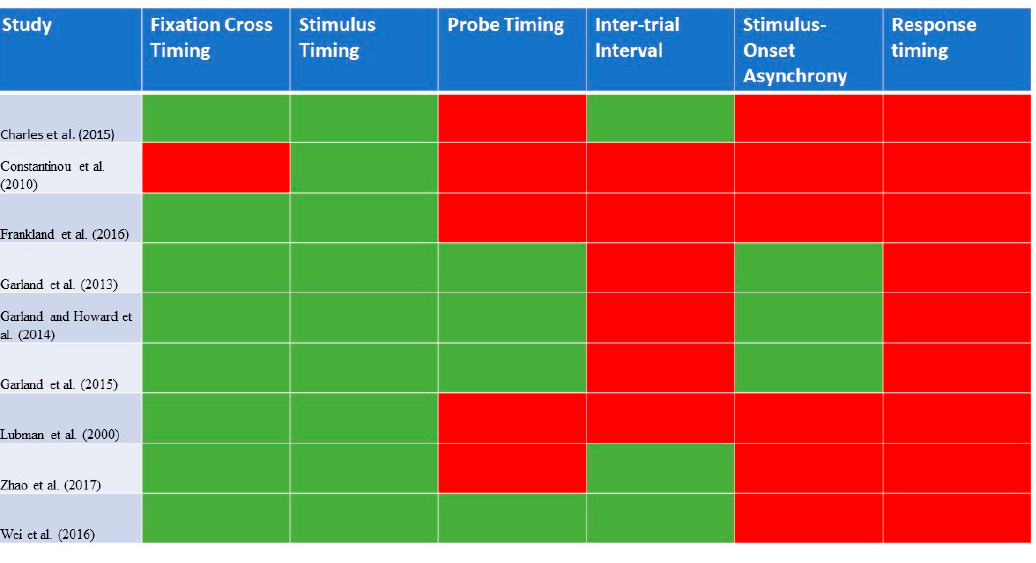
Figure 1. A graphical representation of the details of the Visual Probe Task that were reported in each of the identified studies for opioid use disorder (n = 8). Green highlights: reported in study; red highlights: not reported in study.